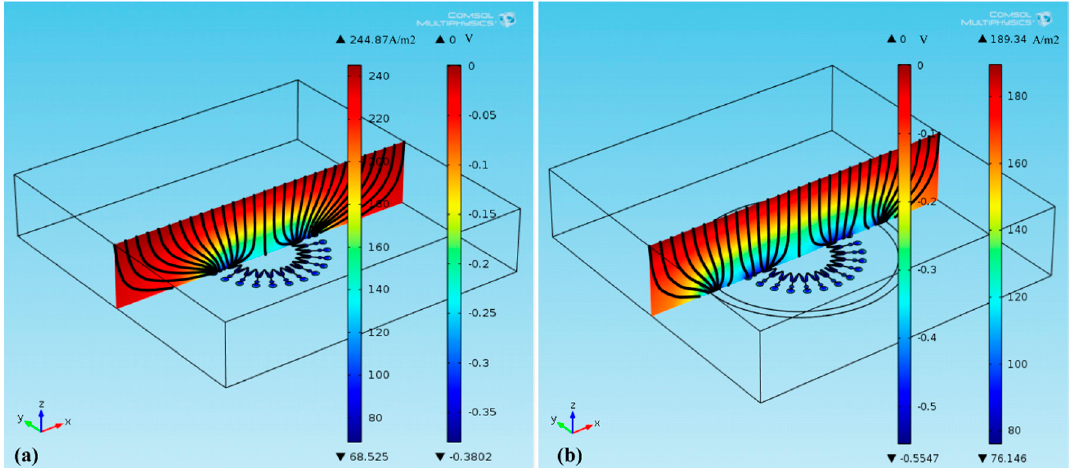
Figure 4. Current density distribution at the mold surface, and potential distribution and current-density streamline at the electrolyte cross-section: ( a ) without a second cathode; ( b ) with a second cathode.